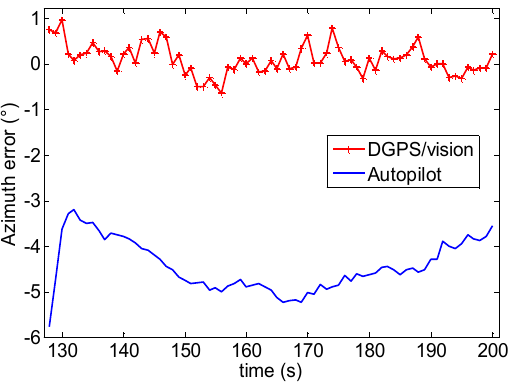
Figure 24. Azimuth error (°) as a function of time (Test 1-time frame 1).